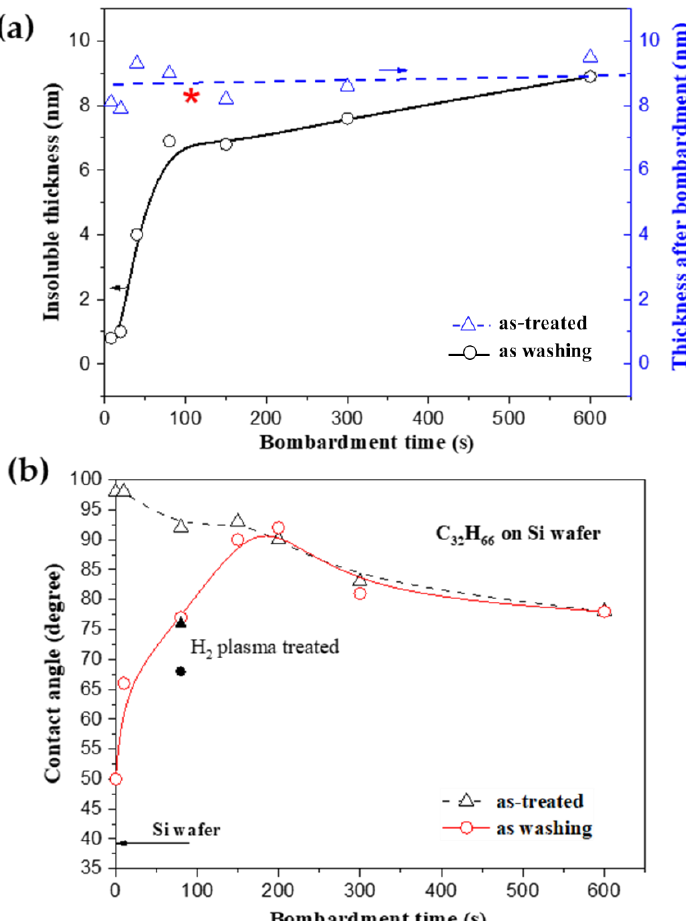
Figure 8. Insoluble thickness of the C 32 H 66 thin films prepared at the concentration of 0.3% w/v, as a function of hyperthermal bombardment fluence ( a ); effect of hydrogen bombardment on wettability of thin film surface ( b ). * represents the thickness after 100 s of H plasma treatment (plasma fluence is not measured), and (cid:78) and • represent the thin films after same treatment, with and without hexane-washing,